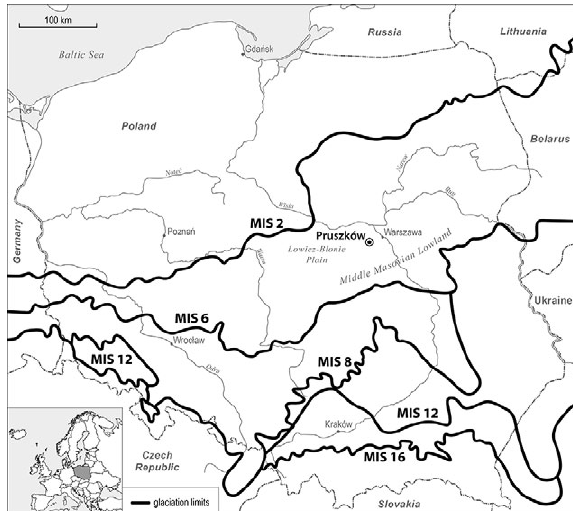
Fig. 1. Location of Pruszków in relation to the extents of Pleistocene glaciations in Poland. Ice limit acc. to Marks et al.